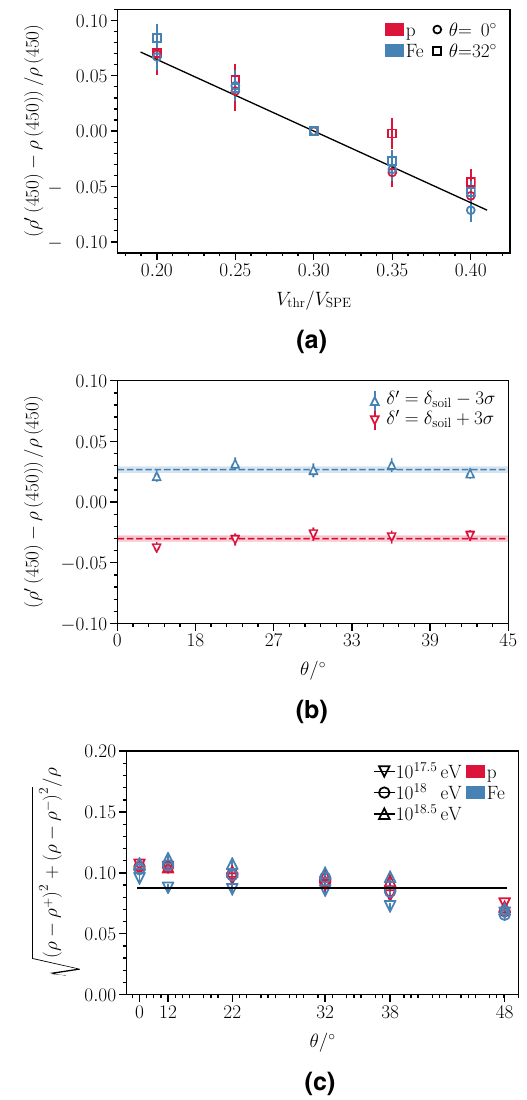
Fig. 9 Relative difference of the reconstructed Δρ( 450 ) obtained with QGSJetII- 04 , for proton and iron: a for different thresholds of discrim- ination, up to ± 10% of the appointed value of 0 . 3 × V SPE , at an energy of 10 18 eV, and for two zenith angles; b for soil density variations of 3 σ around the measured mean value of δ soil = 2 . 380g / cm 3 in bins of shower zenith angle θ ; and c for variations of ± 15% of the slope parameter β as function of θ at different energies